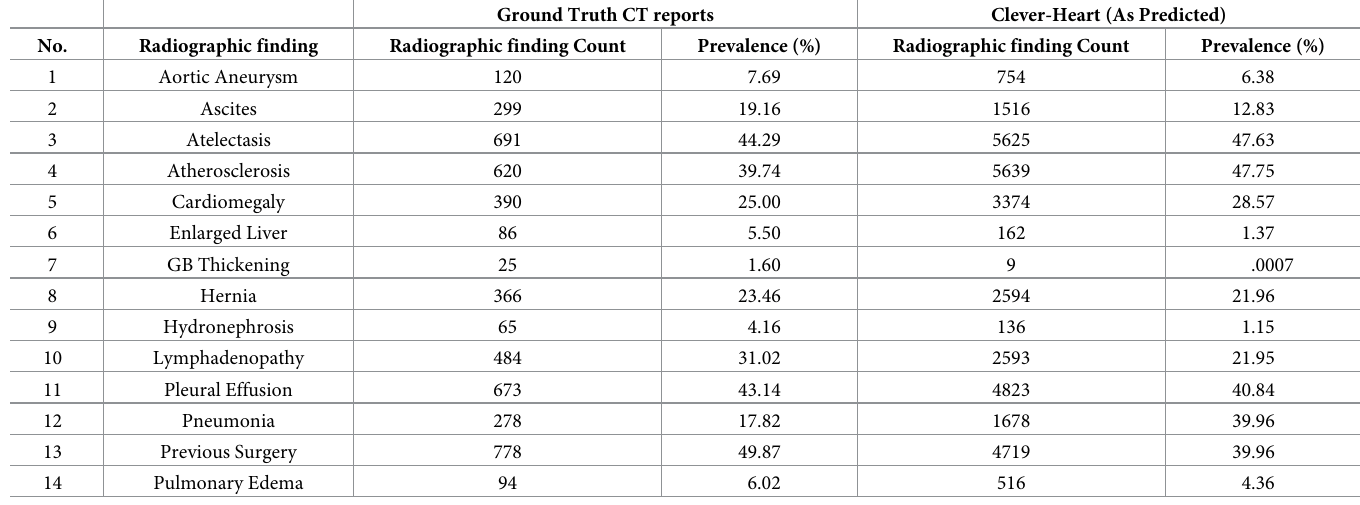
Table 1. Prevalence of radiographic findings between the ground truth cohort (manually annotated reports) and the Clever-Heart cohort. For the ground truth cor- pus, the prevalence percentage is calculated based on known, manually annotated ground truths. For Clever-Heart, values are based on predictions from the CNN model. Ground Truth CT